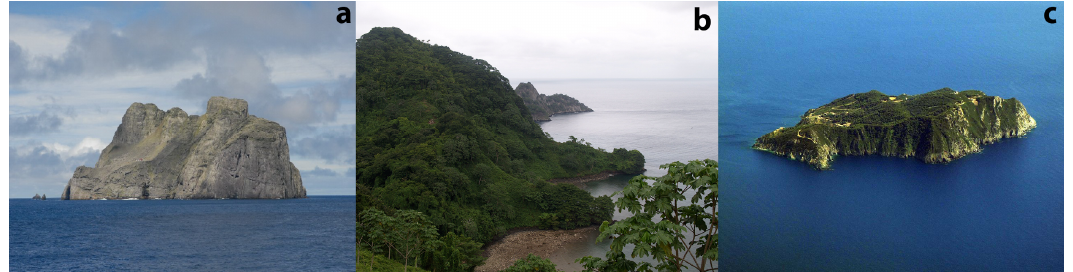
Figure 2. Three islands that are home to the anoles in the ETP. ( a ) Isla Malpelo, ( b ) Isla Cocos, ( c ) Isla Gorgona.